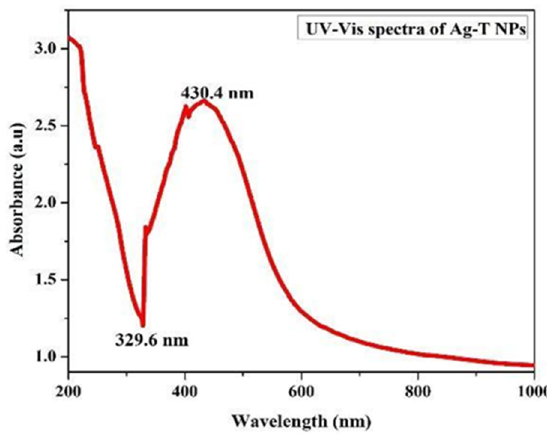
Figure 1. The UV-Vis absorption spectrum of Ag-T-NPs.